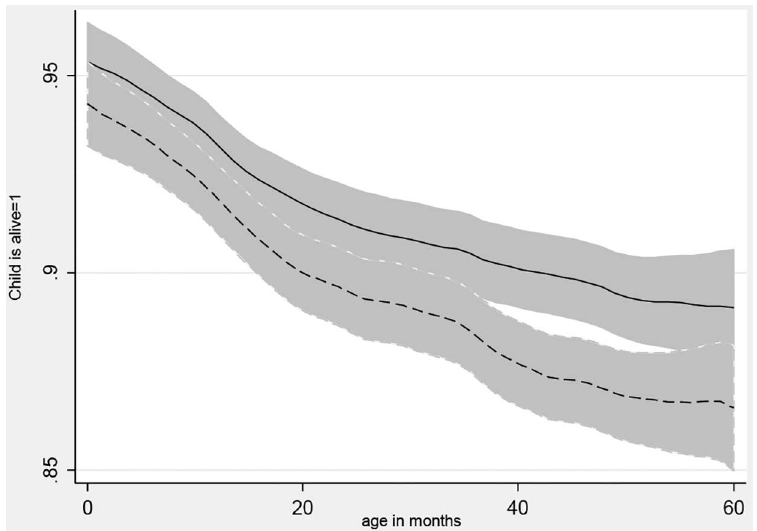
Fig 2. Child survival by child age and household remoteness. Notes: A local polynomial smoothing regression of whetherthe child is alive at each month of age, stratified by place of residenceand the presence of seasons. Remote with seasons is dashedline. 95% ConfidenceIntervals included.